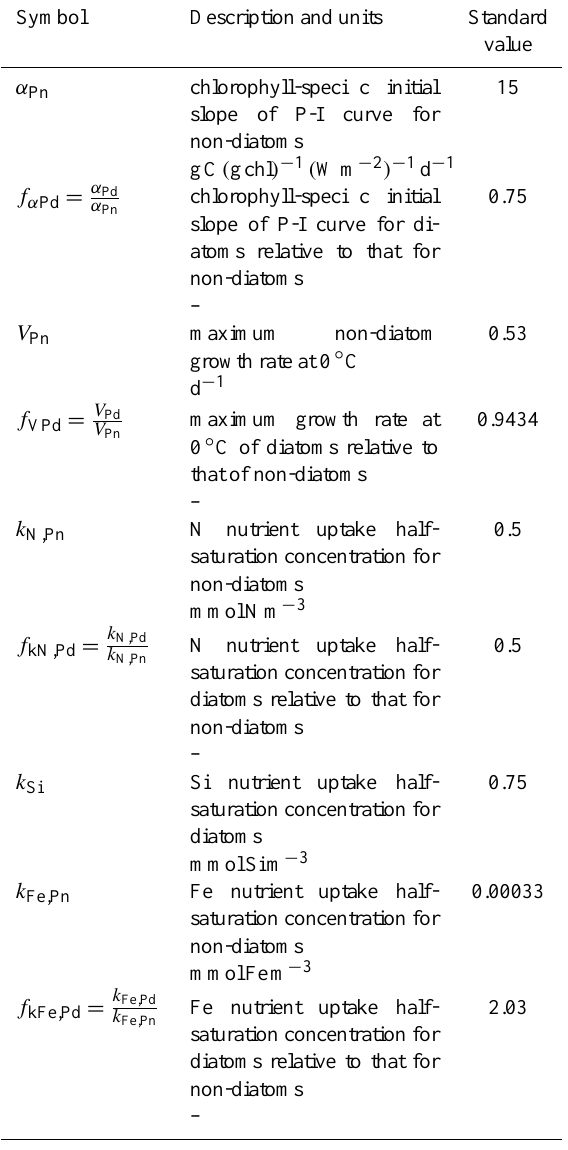
Table A1. MEDUSA phytoplankton parameters (MarMOT 1.1 con-